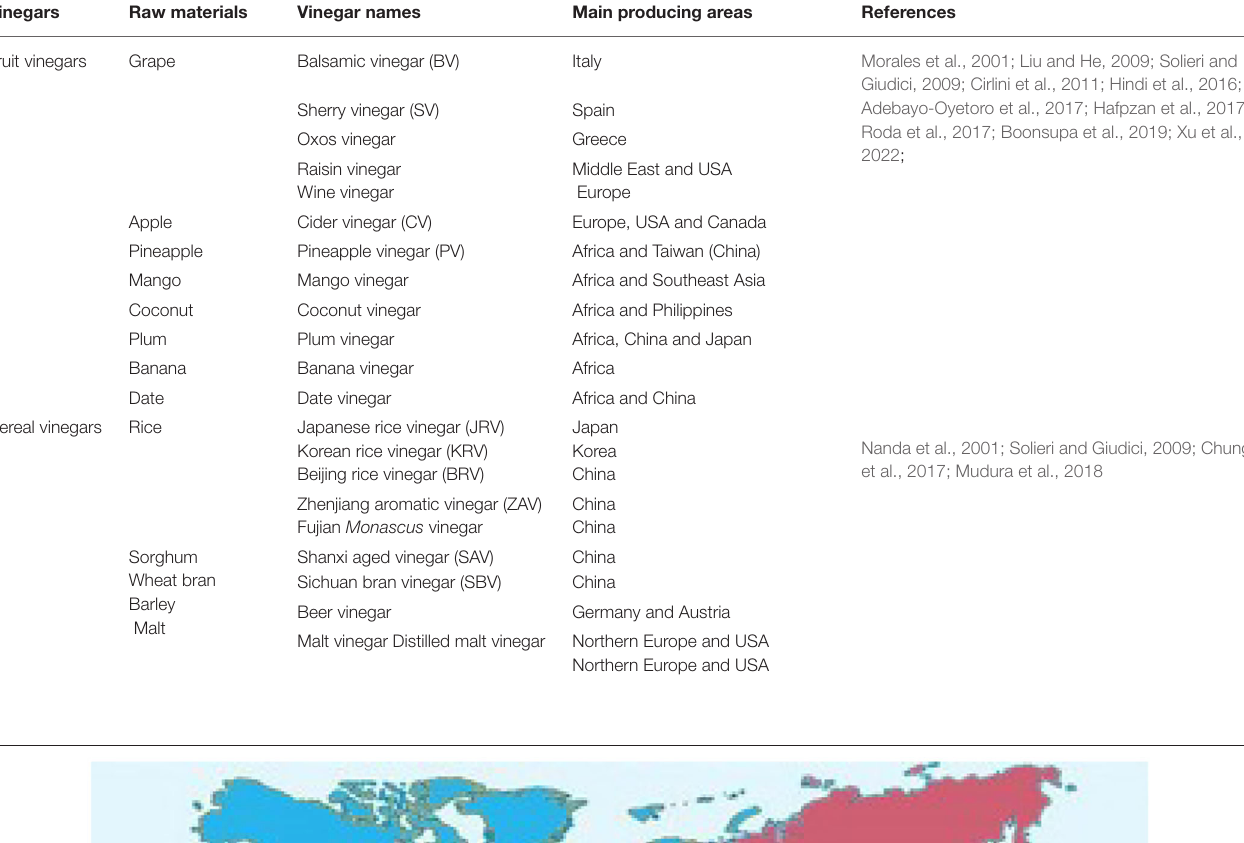
TABLE 1 | Some kinds of vinegar in the world. Vinegars